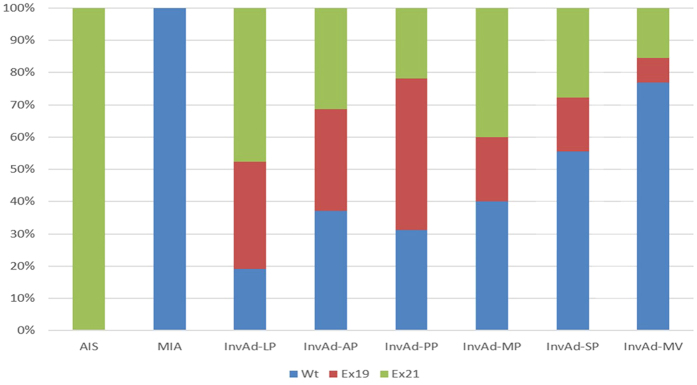
Percentages for the 3 EGFR statuses in each adenocarcinoma subtype based on the 2011 IASLC/ATS/ERS classification.